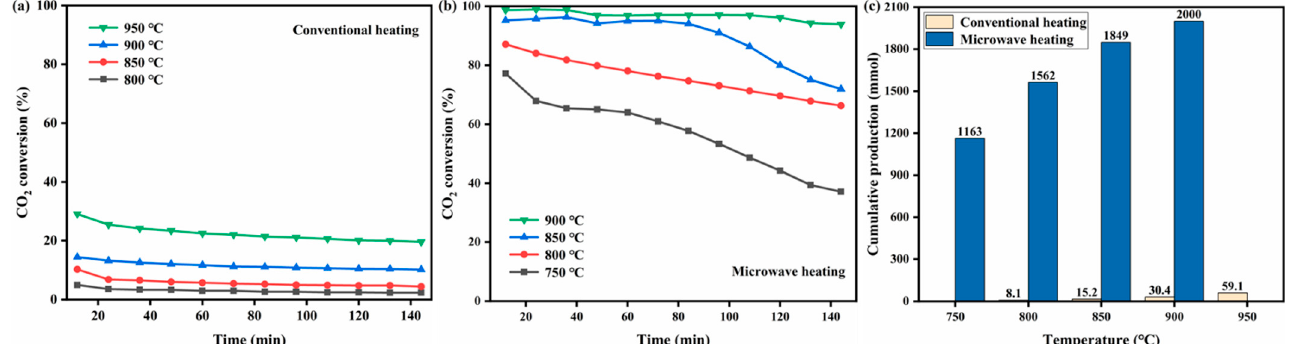
Figure 2. ( a ) Effect of gasification temperature under conventional heating; ( b ) Effect of gasification temperature under microwave heating; ( c ) Production of CO under microwave heating and conventional heating with the reaction times of 144 min.